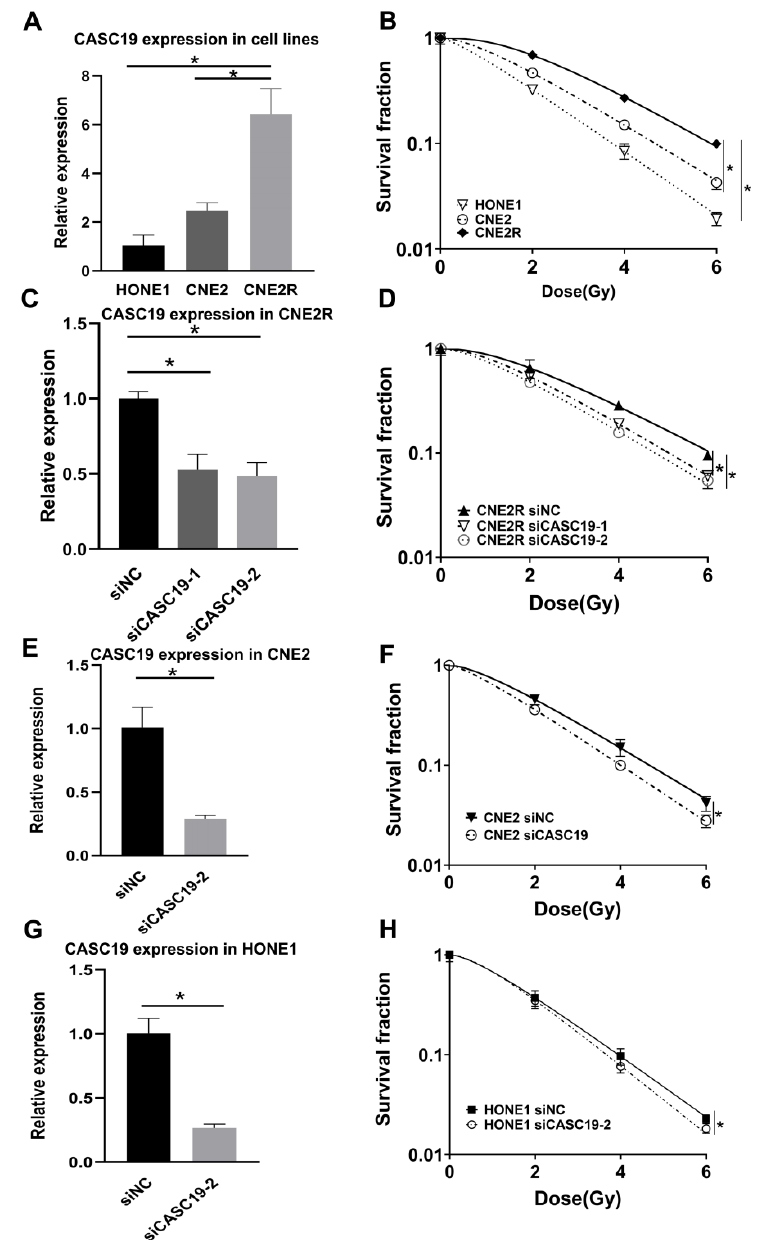
Figure 3. Relationship of lncRNA CASC19 expression with radiosensitivity of NPC cells. ( A ) Reverse-transcription quantitative PCR (RT-qPCR) assay of CASC19 expression in HONE1, CNE2, and CNE2R cells. ( B ) The survival factions of HONE1, CNE2, and CNE2R cells detected by clone formation assay. ( C ) The efficiency of CASC19 siRNA transfection in CNE2R cells. ( D ) Dose responses of survival factions of CNE2R cells after transfection of siCASC19-1, siCASC19-2, and control siRNA, respectively. ( E , G ) The influence of si-CASC19-2 on the expression of CASC19 in CNE2 cells and the survival fraction of CNE2 cells after irradiation. ( F , H ) The influence of si-CASC19-2 on the expression of CASC19 in HONE1 cells and the survival fraction of HONE1 cells after irradiation. * p < 0.05 between indicated groups.